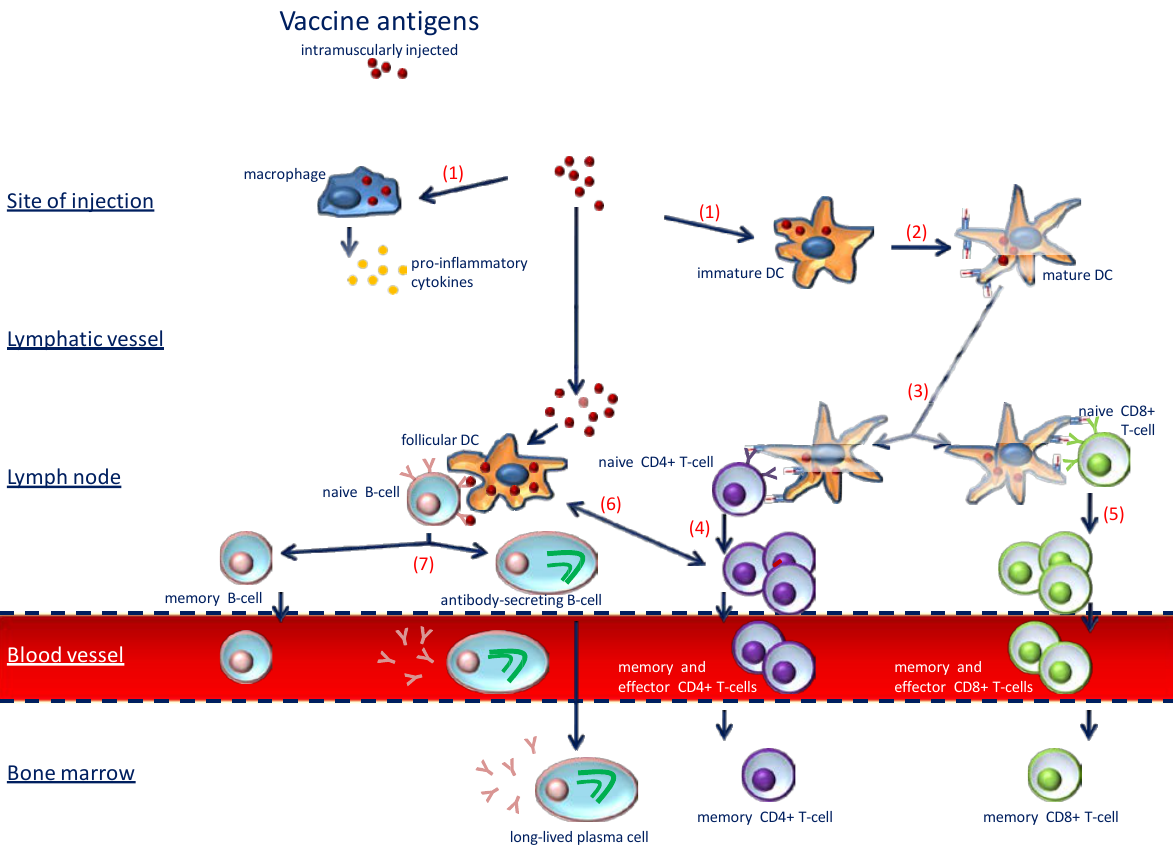
Figure 2. Schematic representation of the vaccine immune response. Administration of vaccine antigens induces the activation of the innate immune system. Antigens are first taken up by antigen-presenting cells ( 1 ). This local innate immune response facilitates maturation of dendritic cells (DCs) ( 2 ). Mature DCs migrate into lymph nodes ( 3 ), where they induce activation and clonal expansion of naive CD4 + ( 4 ) and CD8 + ( 5 ) T-cells. The activation and differentiation of naive B-cells is induced by antigen and CD4 + T helper cells ( 6 ) as well. Naive B-cells differentiate into memory B-cells and antibody-secreting B-cells ( 7 ). (Adapted from Lang et al.